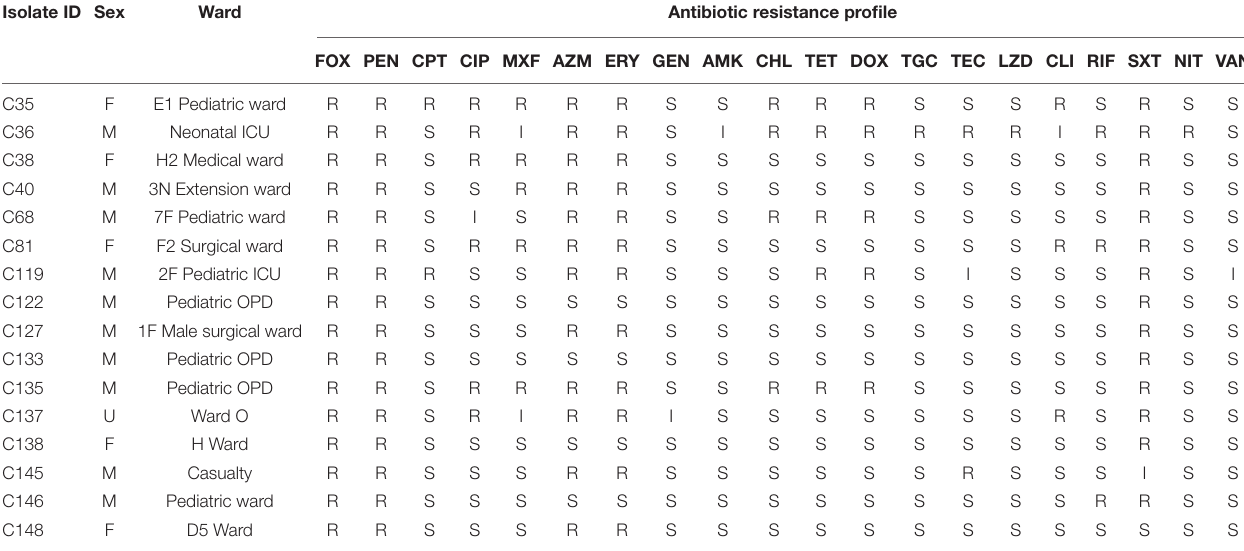
TABLE 1 | Antibiotic susceptibility and demographic characteristics of the MRSE collected from blood cultures. Isolate ID Sex Ward Antibiotic resistance profile